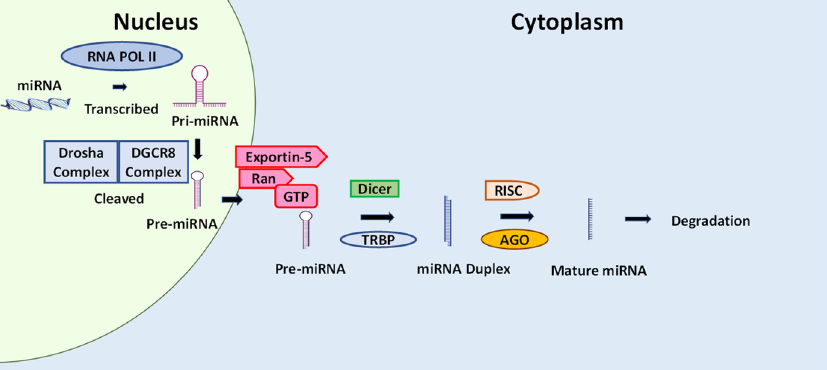
Figure 7. The proposed effect of fucoxanthin on miRNA. The red arrow indicates that inhibition is induced by fucoxanthin. miRNAs are developed from pri-miRNAs that are transcribed from other independent miRNA genes.